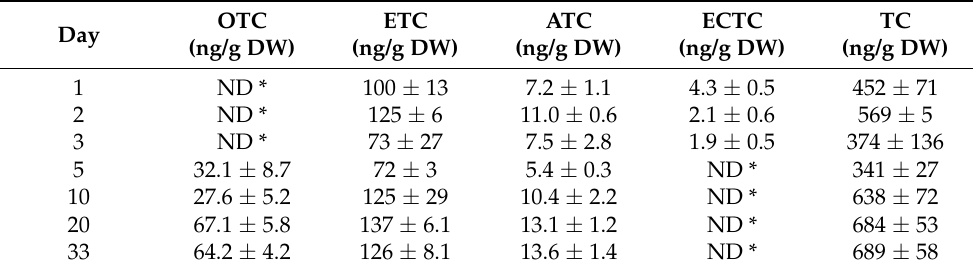
Table 1. Average antibiotics in ng/g dry weight (DW) for a sick cow bedding compost windrow over a 33-day period. The antibiotics analyzed include oxytetracycline (OTC), 4-epitetracycline